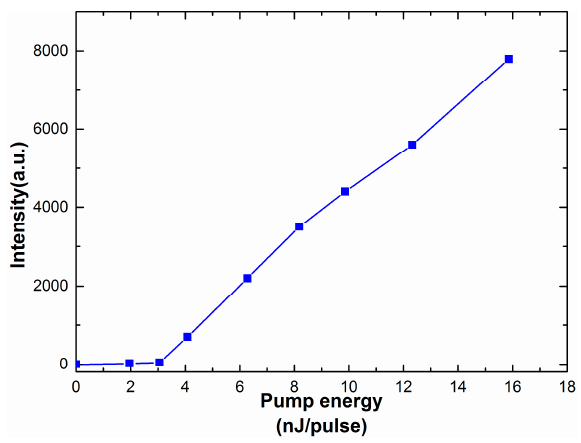
Figure 8. The emitted intensity of sample B as a function of pump energy.